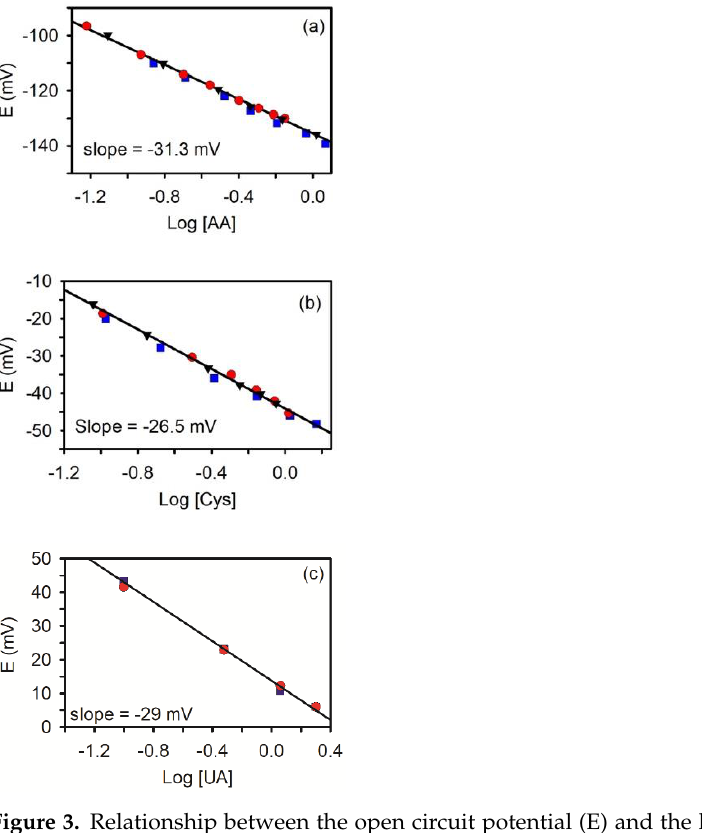
Figure 3. Relationship between the open circuit potential (E) and the logarithm of concentration (in mM) for ( a ) ascorbic acid (AA), ( b ) cysteine (CYS), and ( c ) uric acid (UA). Each symbol represents a separate experiment with a different NPG electrode. The solid line represents the linear least-squares regression line. R 2 > 0.99.